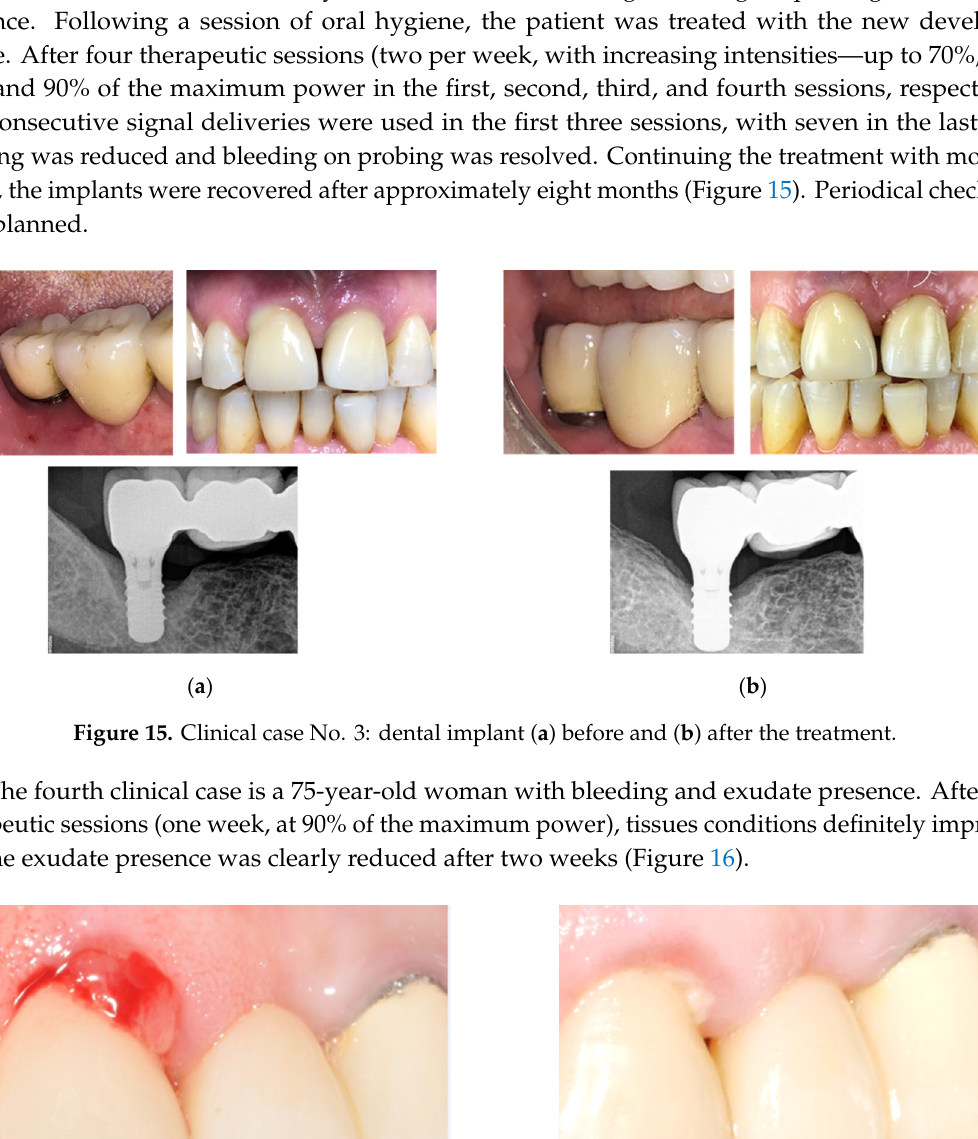
( b ) Figure 13. Clinical case No. 1: dental implant ( a ) before and ( b ) after the treatment. The second clinical case is a 69-year-old man with pain and bleeding on probing. Following a session of oral hygiene, the patient was treated with the new developed device. After four therapeutic sessions (two per week, each consisting of seven consecutive therapeutic signal deliveries, up to 90% of the maximum power), the implant could be considered recovered and pain disappeared after the first therapeutic session (Figure 14). Monthly check-ups were planned and follow-up X-rays confirmed the positive outcome of the therapy.